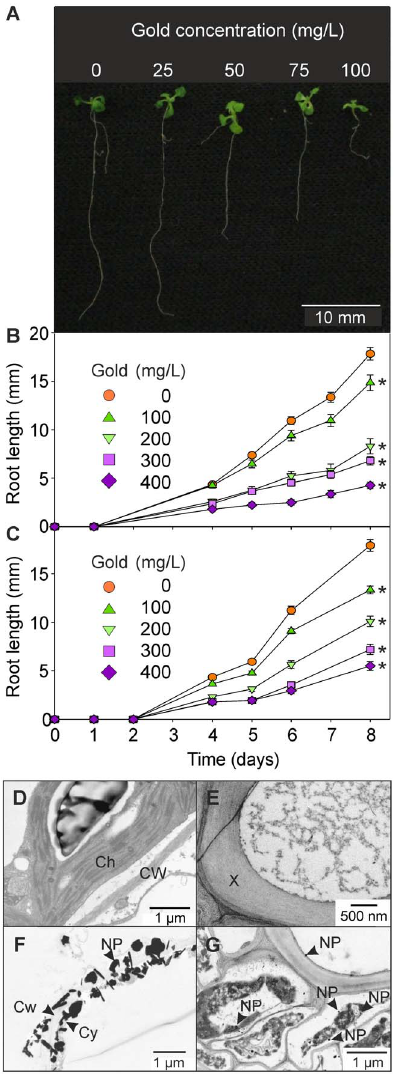
Figure 1. Growth of Arabidopsis seedlings in the presence of gold. (A) Appearance and (B) root length of ten-day-old seedlings grown on agar plates containing a range of gold concentrations, as K(AuCl 4 ). (C) Root length of ten-day-old seedlings grown on agar plates containing a range of gold concentrations, as AuCl 3 . Results are the mean from 30 biological replicates 6 SD. * = significantly different from no gold, at day 8 ( p , 0.001). Transmission electron micrographs showing gold nanoparticles in tissue of plants grown on agar plates containing 100 mg/L gold. (D) Leaf mesophyll and (E) leaf vascular tissue; (F) root cortex and (G) root vascular tissue. NP, nanoparticle; Cy, cytoplasm; Cw, cell wall, X, xylem; Ch, chloroplast.